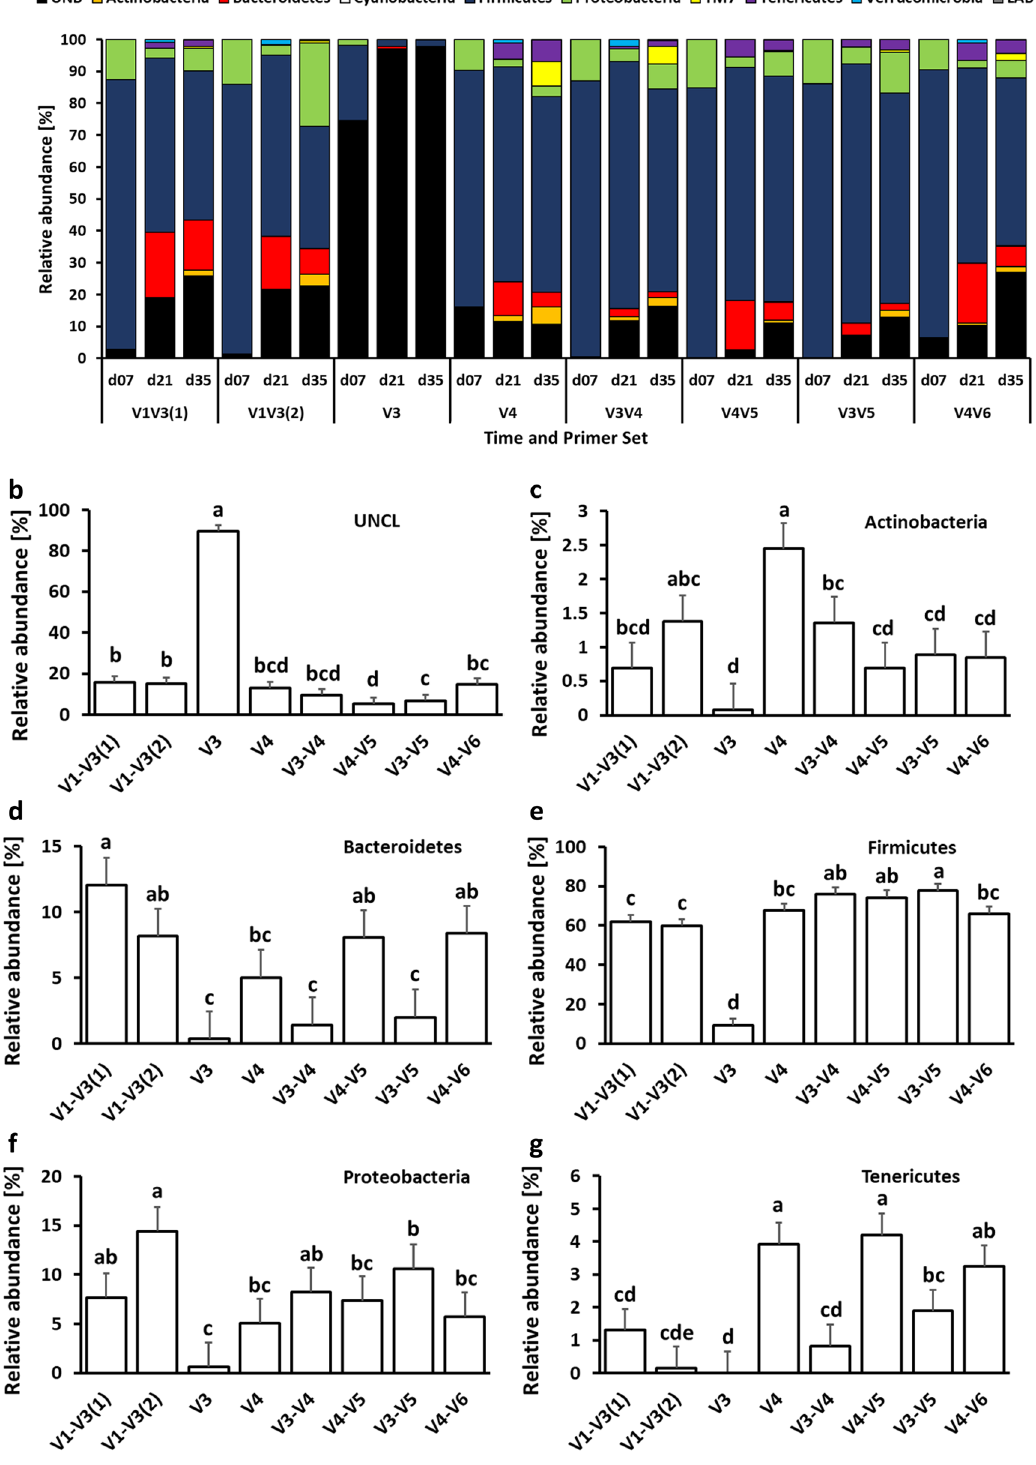
Figure 3. Changes in relative bacterial abundance (%) in chicken cecal content at phylum level. (a) Taxonomic profile of chicken cecal microbiota. Effect of primer sets on the relative abundance of (b) unclassified bacteria (UNCL), (c) Actinobacteria, (d) Bacteroidetes, (e) Firmicutes, (f) Proteobacteria, and (g) Tenericutes. Only significant ( P < 0.05) data are shown and only first 6 phyla with the highest abundance are shown. Different letters denote statistically significant ( P < 0.05) differences between primer